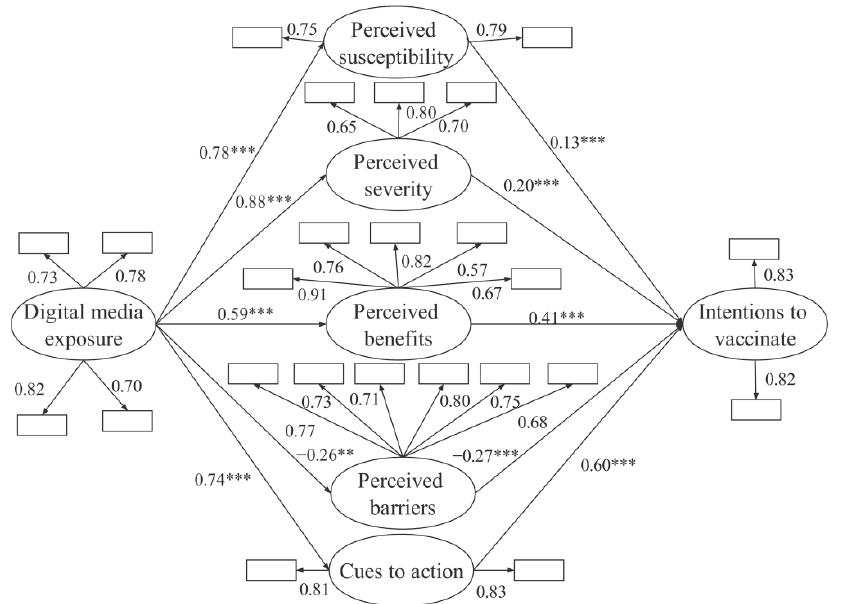
Figure 1. Results from the structural equation modeling procedure for the final model: Values indicate standardized regression weights and the path load factor. Notes: * p < 0.05, t > 1.96; ** p < 0.01, t > 2.58; *** p < 0.001, t > 3.29.